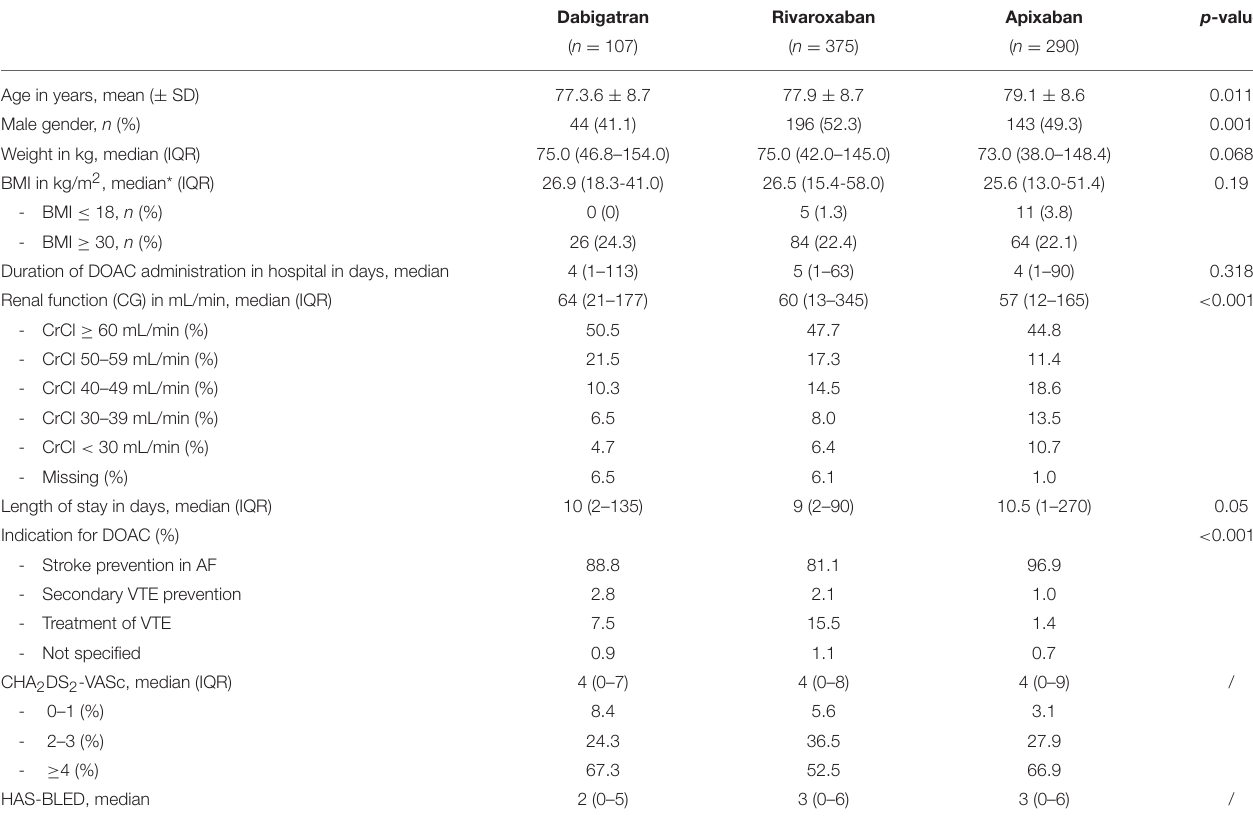
TABLE 1 | Demographic data and specific characteristics of included patients.